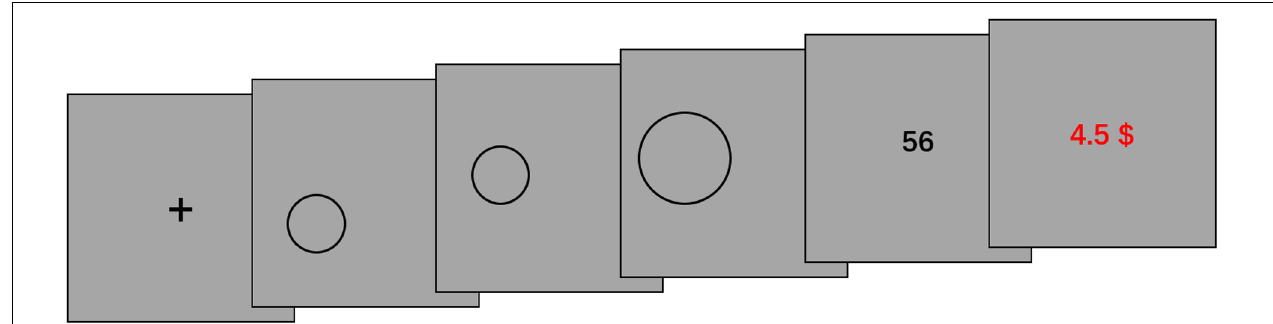
FIGURE 7 | The procedure used in Study 3. For each trial, a fixation cross was presented for 500 ms. Then participants entered the adjustment phase. They could adjust the position and size of the circle by dragging the mouse (the left mouse button for size and the right mouse button for position). Participants pressed the space key to end the adjustment phase. They could also directly press the space key without making any adjustment. After the adjustment phase, the score they received appeared for 1 s. Then, their reward amount appeared on the screen for 750 ms. The reward, which served as an immediate reward feedback, was based on the M of all the scores participants